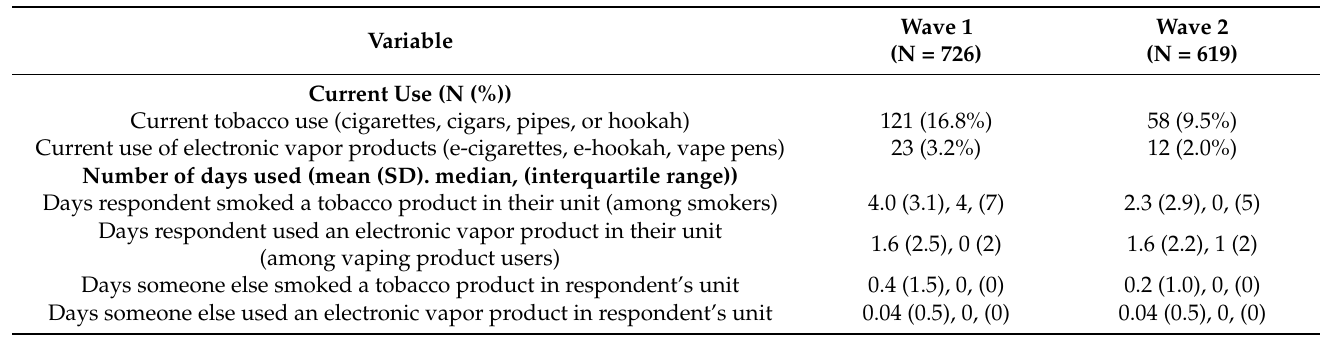
Table 2. Combusted tobacco or electronic vapor product use and number of days used by residents or guests inside residential units within the past 7